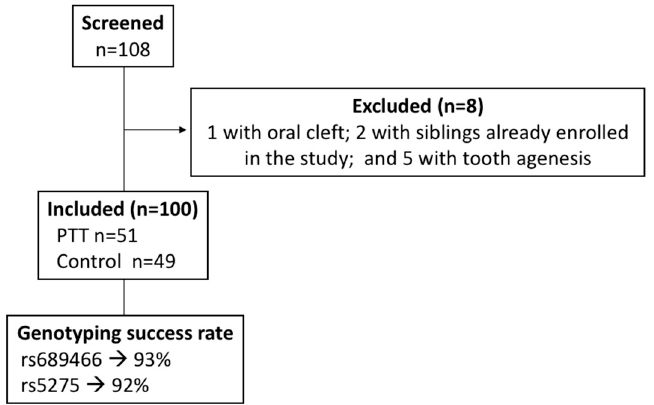
Figure 3. Flow diagram.